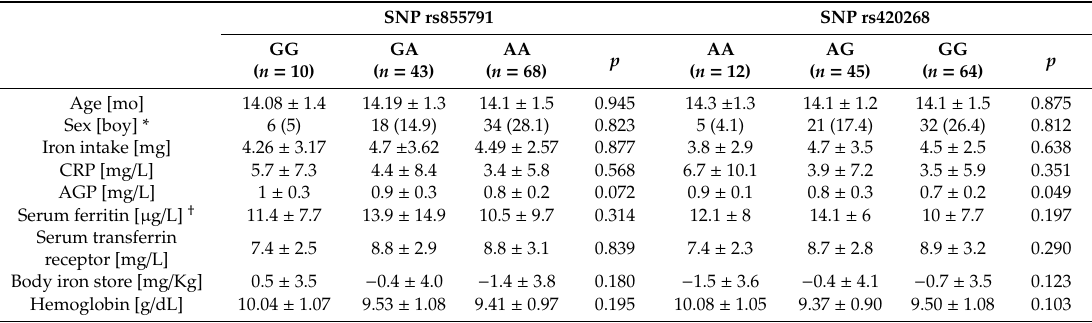
Figure 2. Distribution of Iron deficiency, anemia and iron deficiency anemia status across genotypes of SNPs